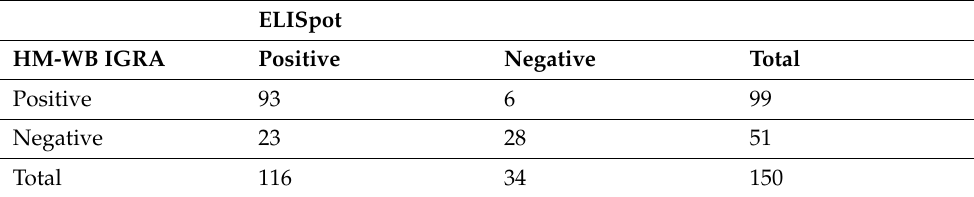
Table 1. Agreement between ELISpot and HM-WB IGRA in 150